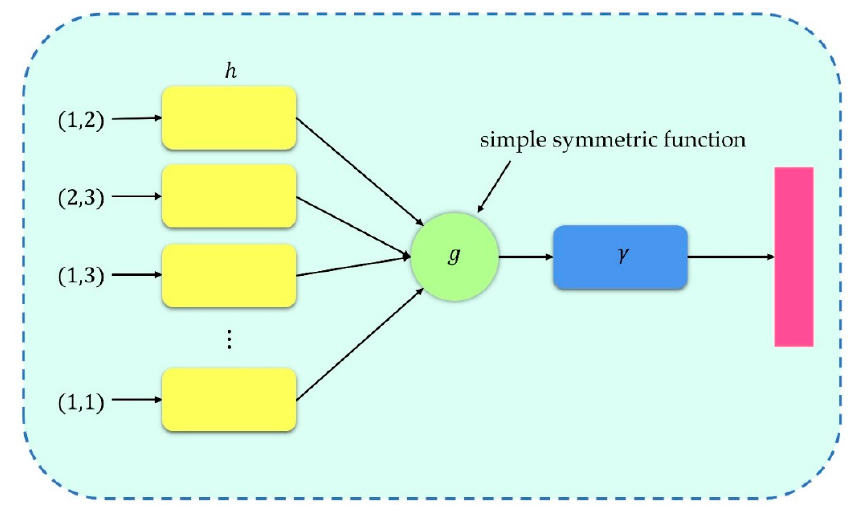
Figure 6. Basic modules of the neural network.